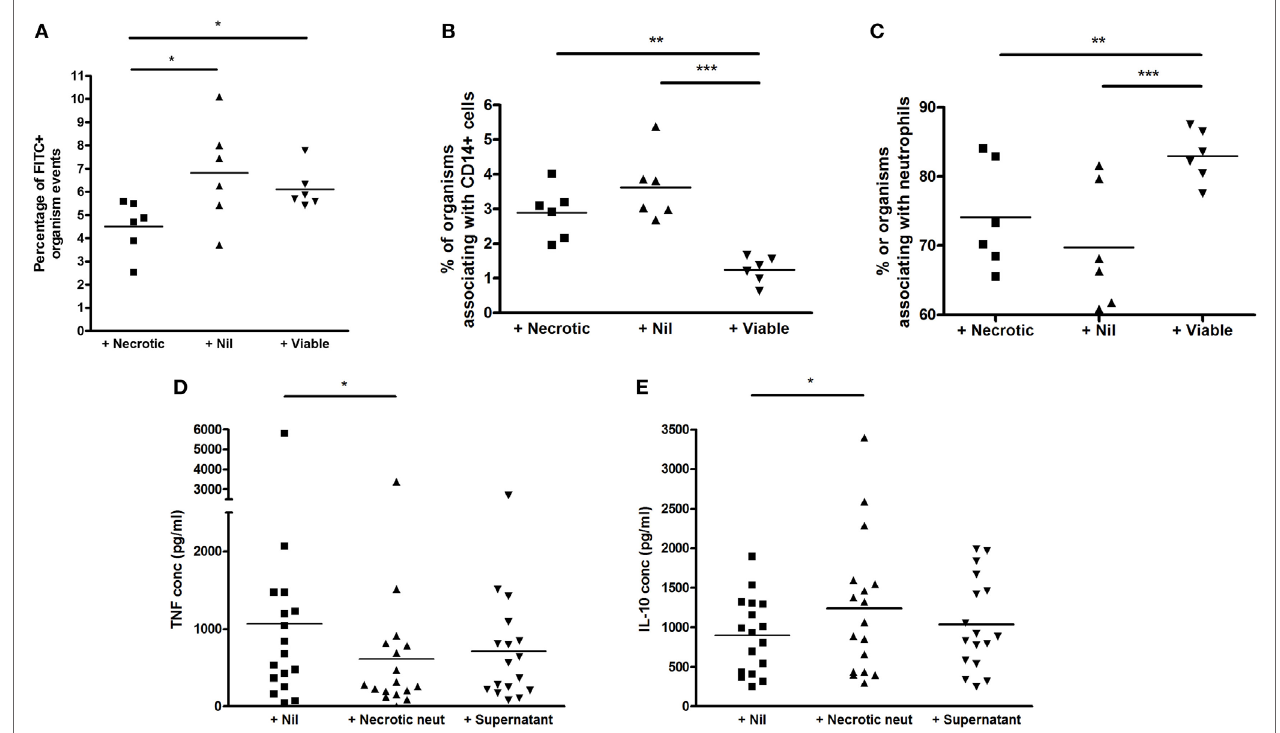
FigUre 5 | Effect of viable and necrotic neutrophil augmentation on phagocytosis of FITC-labeled M. bovis BCG, and differential effect of necrotic neutrophil augmentation versus supernatant of necrotic neutrophils on cytokine release in blood. (a–c) Blood from six donors (four independent experiments) was augmented with viable neutrophils, necrotic neutrophils, or medium alone, infected with 2 × 10 5 CFU FITC-labeled M. bovis BCG and incubated for 1 h at 37°C. 2 × 100 mcl aliquots were taken from each sample, incubated with CD14-PE and Viability Dye for 20 min, red blood cells were lysed, trypan blue was added to quench extracellular fluorescence and samples fixed in 2% paraformaldehyde before acquisition on a BD Fortessa flow cytometer. Results are presented as the percentage of BCG-FITC + events (a) , the percentage of BCG-FITC + events associated with CD14 + cells (B) , and the percentage of BCG-FITC + events associated with neutrophils [as defined by forward and side scatter among CD14 negative events (c) ]. (D,e) Blood from 17 donors (4 independent experiments) was augmented with necrotic neutrophils, the supernatant of necrotic neutrophils, or medium alone, infected with 2 × 10 5 CFU M. bovis BCG and incubated for 96 h at 37°C. Samples were centrifuged and supernatants stored at − 80°C until analysis by ELISA for tumor necrosis factor (TNF) (a) or interleukin-10 (B) . Lines represent